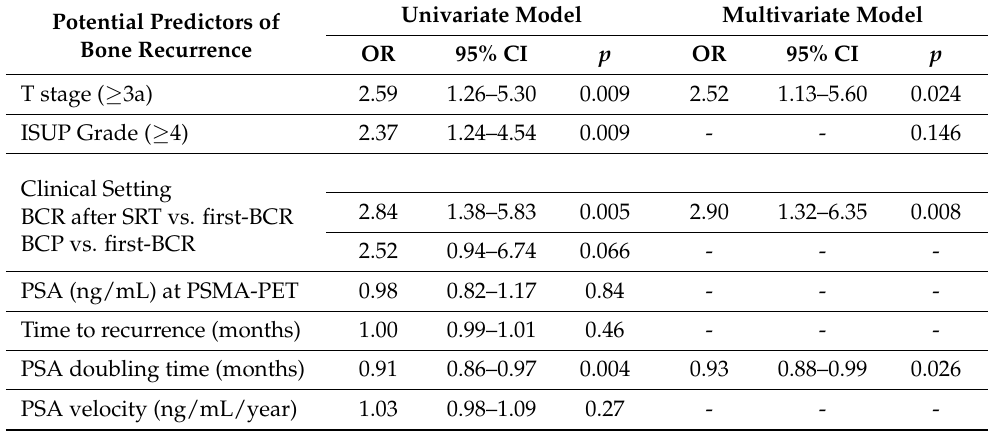
Table 2. Univariate and multivariate logistic regression models for bone disease at